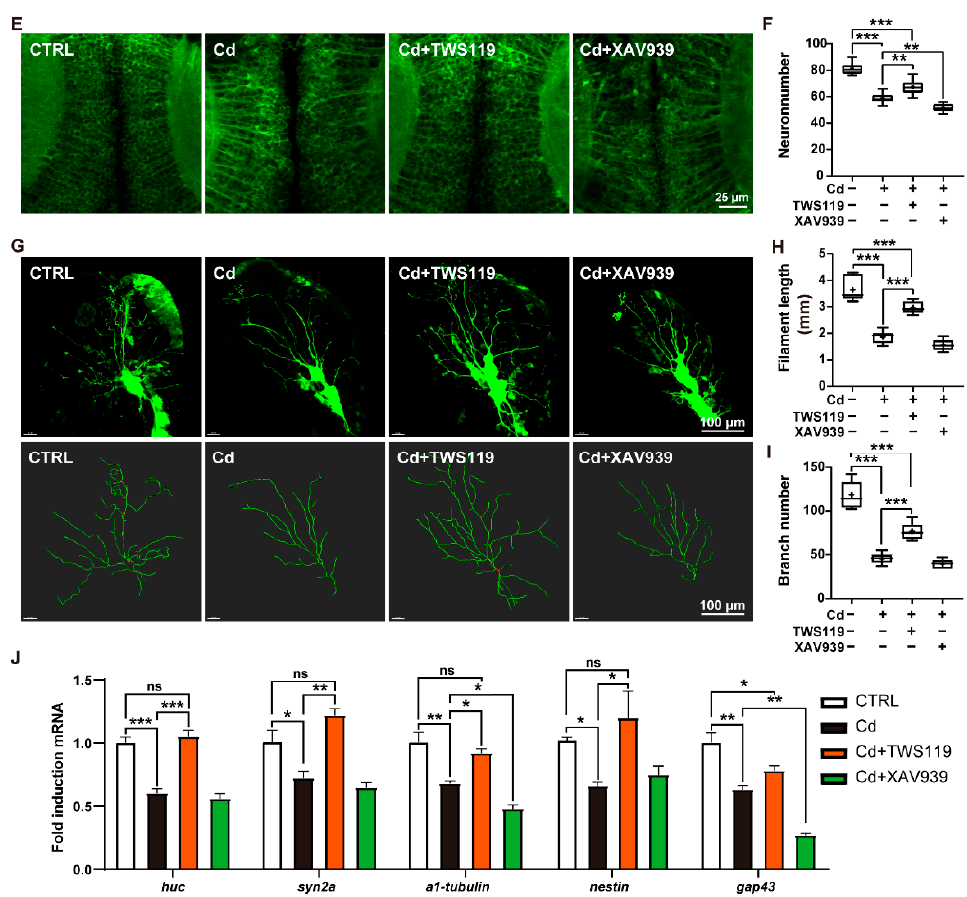
Figure 4. Involvement of zebrafish Wnt signaling pathway in Cd 2+ -induced neurodevelopmental disorders. ( A,B ) Fluorescence imaging of 6 dpf Tg(elavl3:EGFP) larvae and statistics of relative fluorescence intensity. ( C , D ) Confocal fluorescence imaging of the telencephalon and midbrain regions, as well as the statistics of telencephalon proportion. ( E , F ) Imaging of the PVL region in 6 dpf Tg(elavl3: EGFP) larvae and density statistics of PVN. ( G – I ) Imaging of trigeminal ganglion neurons and structural analysis in 24 hpf zebrafish embryos. ( J ) Relative expression of genes related to neurodevelopment and differentiation. In histograms, values are represented as mean ± SEM, while in boxplots, values are represented as median and mean, and whiskers show 90% confidence levels. The results of nonparametric test and ANOVA, as well as multiple comparison test are listed in Table S2. “*” indicates significant differences (* p < 0.05, ** p < 0.01, *** p < 0.001).